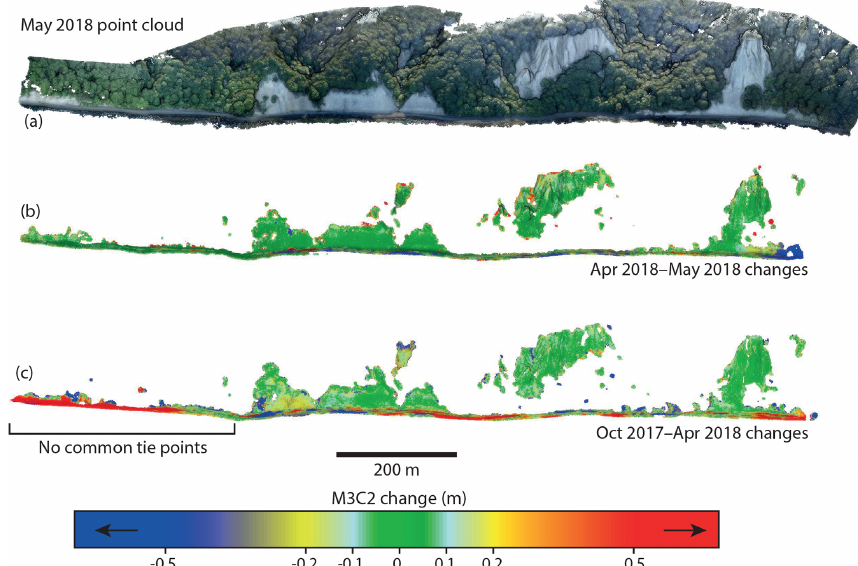
Figure 5. Cloud–cloud differences in the heavily vegetated Königsstuhl section of the coast. (a) May 2018 point cloud showing the extent of the vegetation. (b) M3C2 differences between April 2018 and May 2018 point clouds. The vegetation has been removed using standard deviation and point density filters. Leaf growth results in very high measured changes in the vegetated areas, so only the bedrock cliff sections are shown. (c) M3C2 differences between October 2017 and April 2018 point clouds. A lack of common tie points detected in the left side of the region results in relative distortion of the models and high errors in the change detection. Table 1. Survey